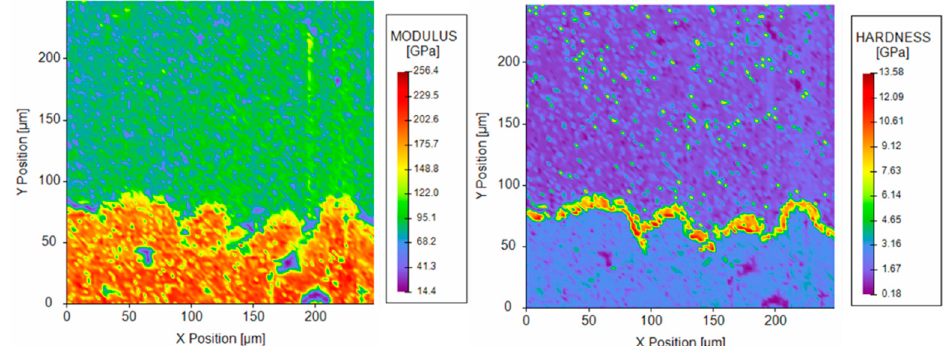
Figure 47. ( Left ) Resultant contour plot of the hardness relative to an indentation grid array performed upon a copper-aluminum cold spray coating and substrate combination following thermal solutionization. The degree of atomic diffusion between the Cu and Al that followed from solution heat treating is clearly illustrated on the ( Left ) contour plot. A diffusion zone clearly formed and multiple intermetallic compounds developed at the particle/substrate interfacial region ( Left ). As for the ( Right ), the mechanically mapped contour plot of hardness relative to an indentation grid array performed upon a copper-Al 365 cold spray coating and substrate combination following a T6 heat treatment is presented.